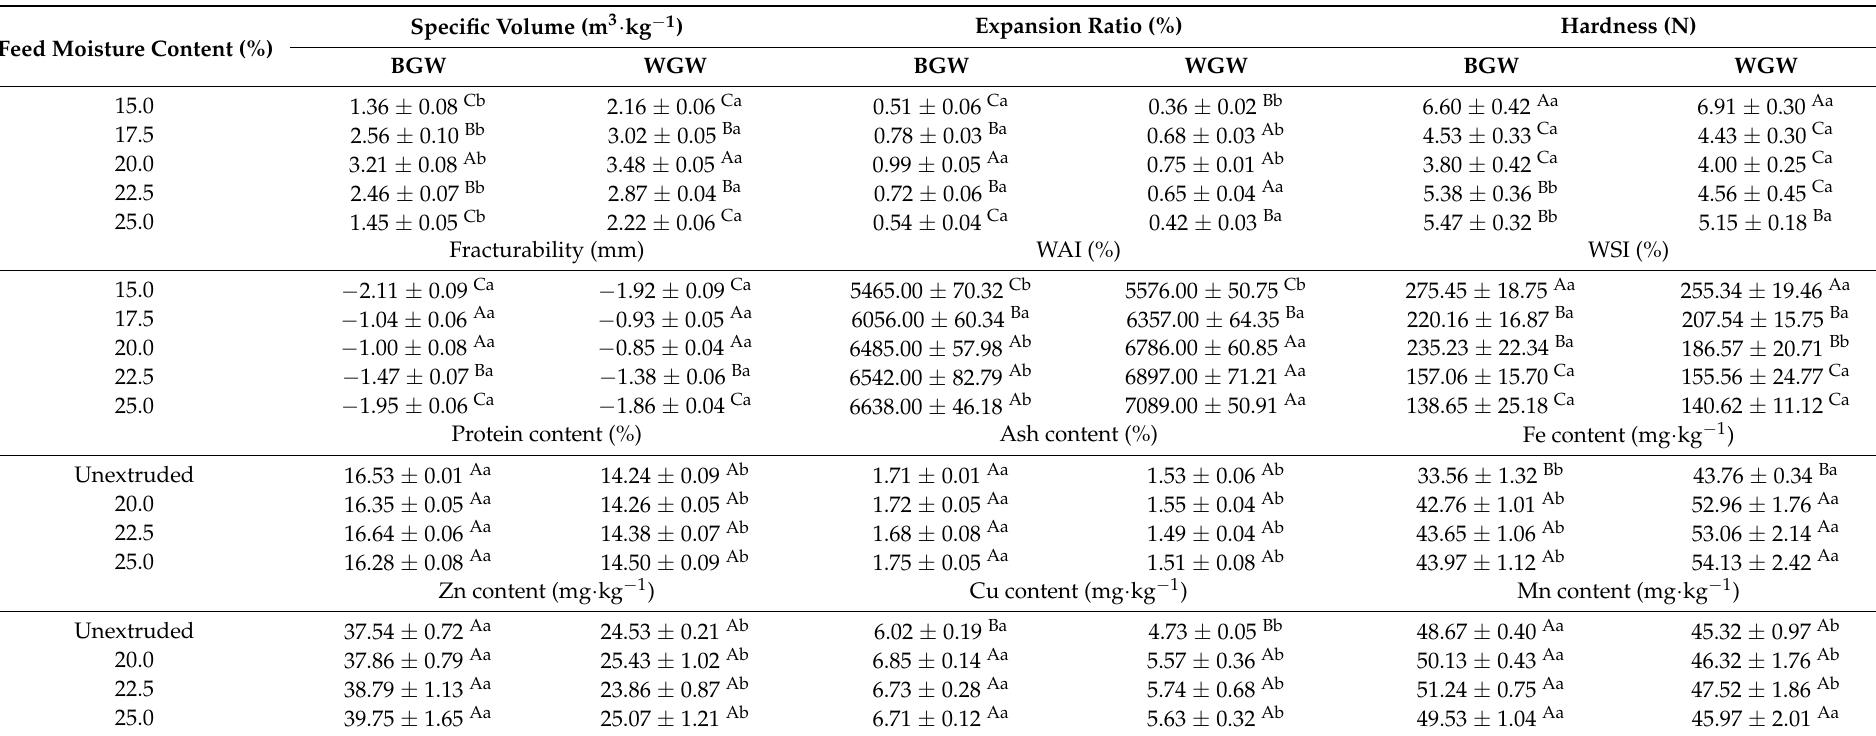
Table 6. Effect of the feed moisture content on the physical properties and nutritional components of the wheat